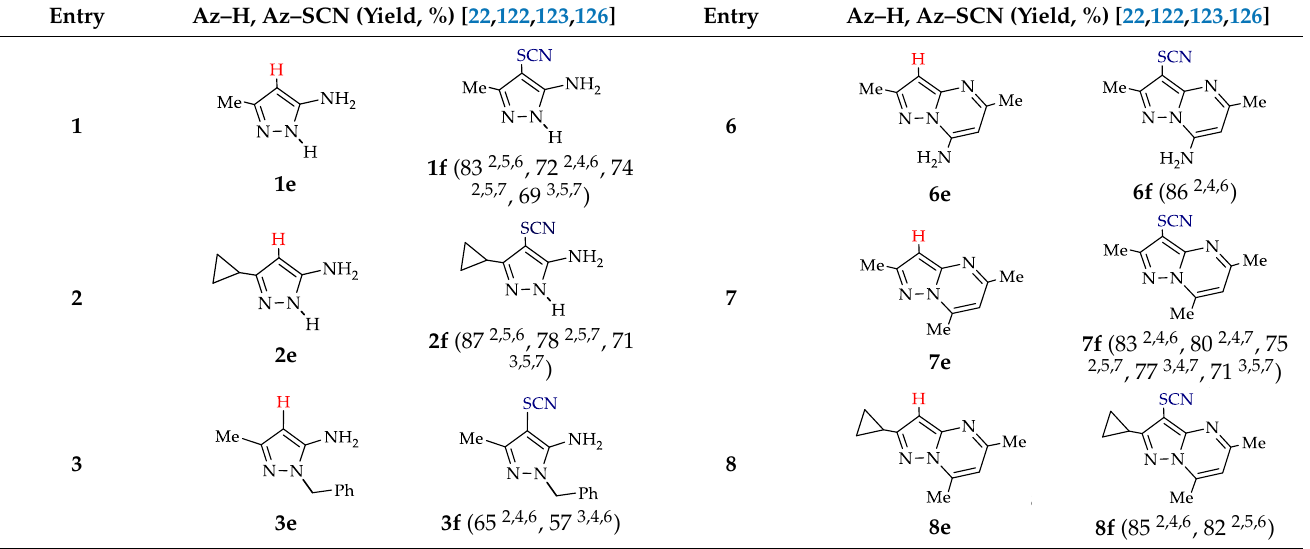
Table 4. C – H An thiocyanation of pyrazole derivatives ( Az‒H ) via (SCN) 2 (approach A) 1 .